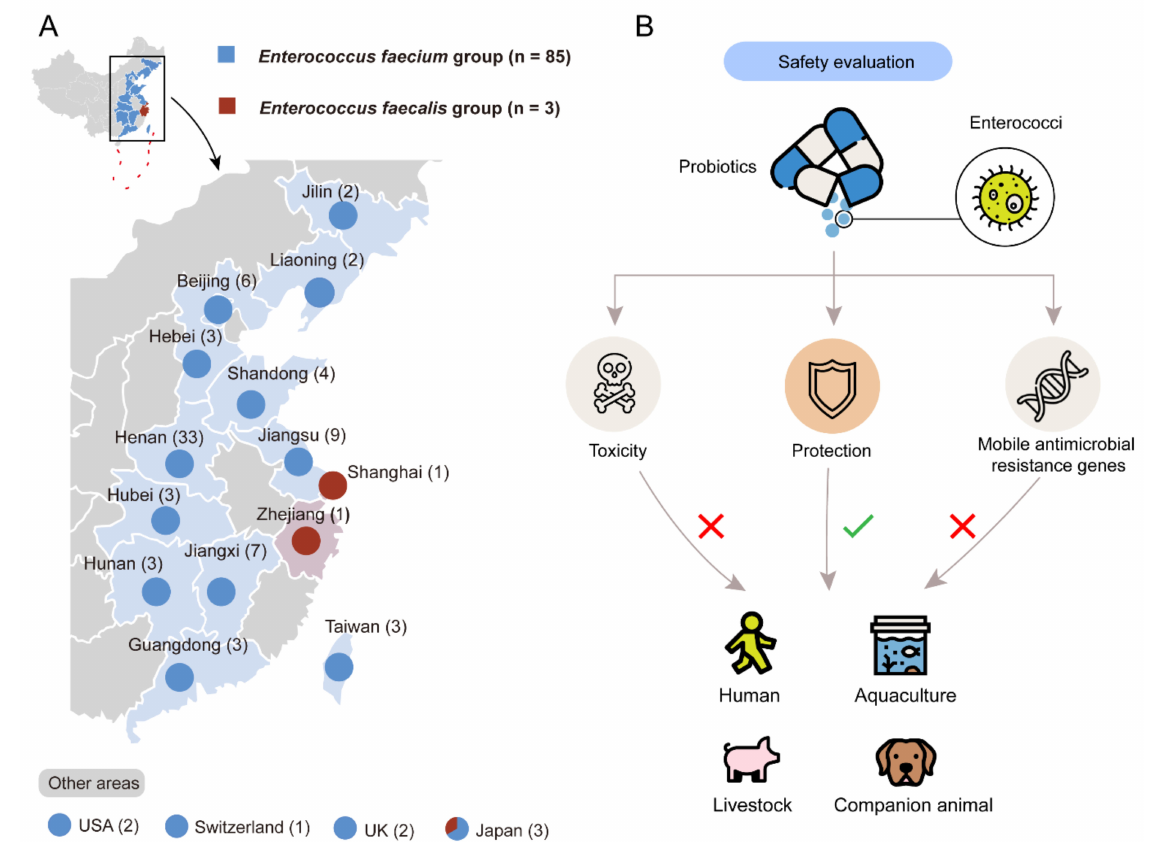
Figure 1. Characterization and evaluation of enterococci from probiotic products. ( A ) Characterization and isolation of enterococci. A total of 88 enterococcal isolates were collected from probiotic products in 12 provinces in China, as well as the USA, UK, Switzerland, and Japan. Numbers in the parentheses indicate the numbers of the enterococci isolates in each place. ( B ) Systematic safety evaluation of probiotic